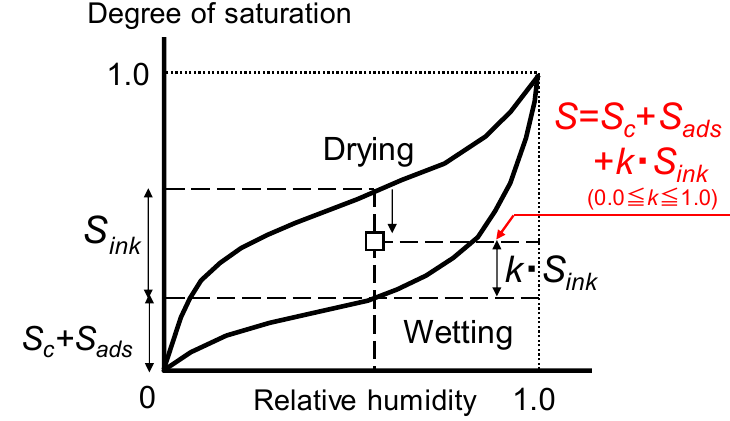
Figure 14. Enhanced moisture isotherm model considering the time-dependent dispersion of ink-bottle water [1,24].